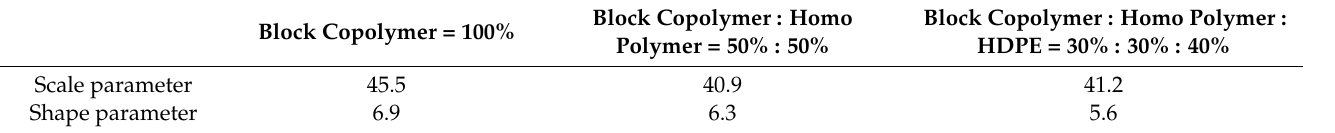
Table 2. Specification of the scale and shape parameters of three types of test samples.